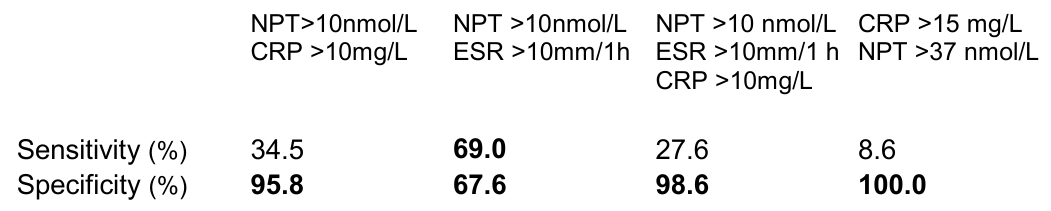
Table 2. A combination of neopterin (NPT) concentrations and other inflammation markers C-reactive protein (CRP) and erythrocyte sedimentation rate (ESR) for differential diagnosis of